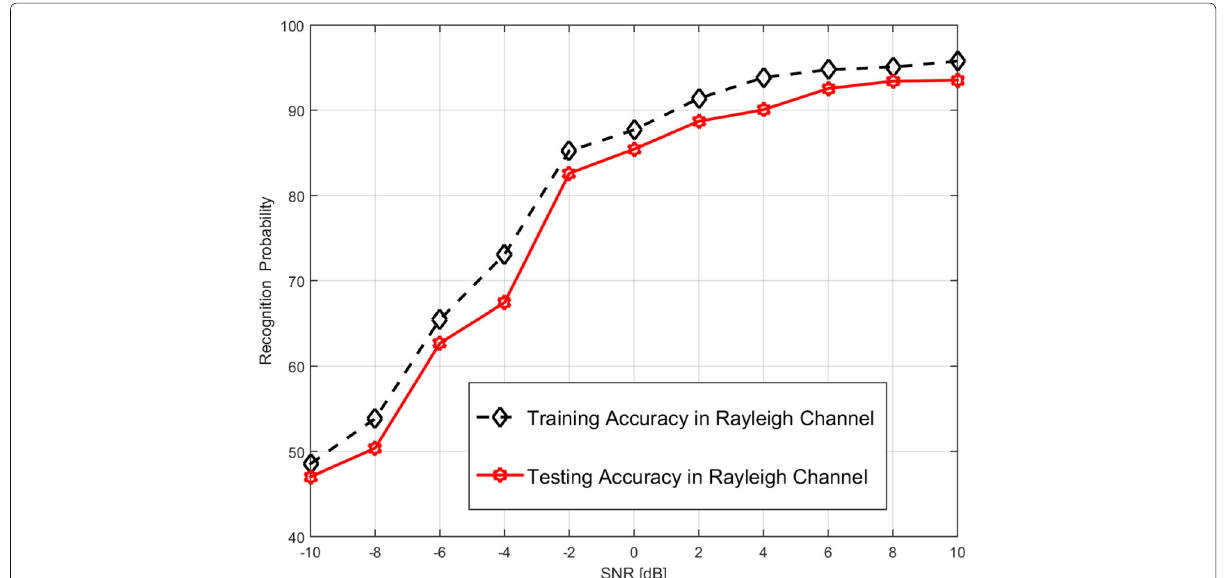
Fig. 6 φ 3 in the Rayleigh fading